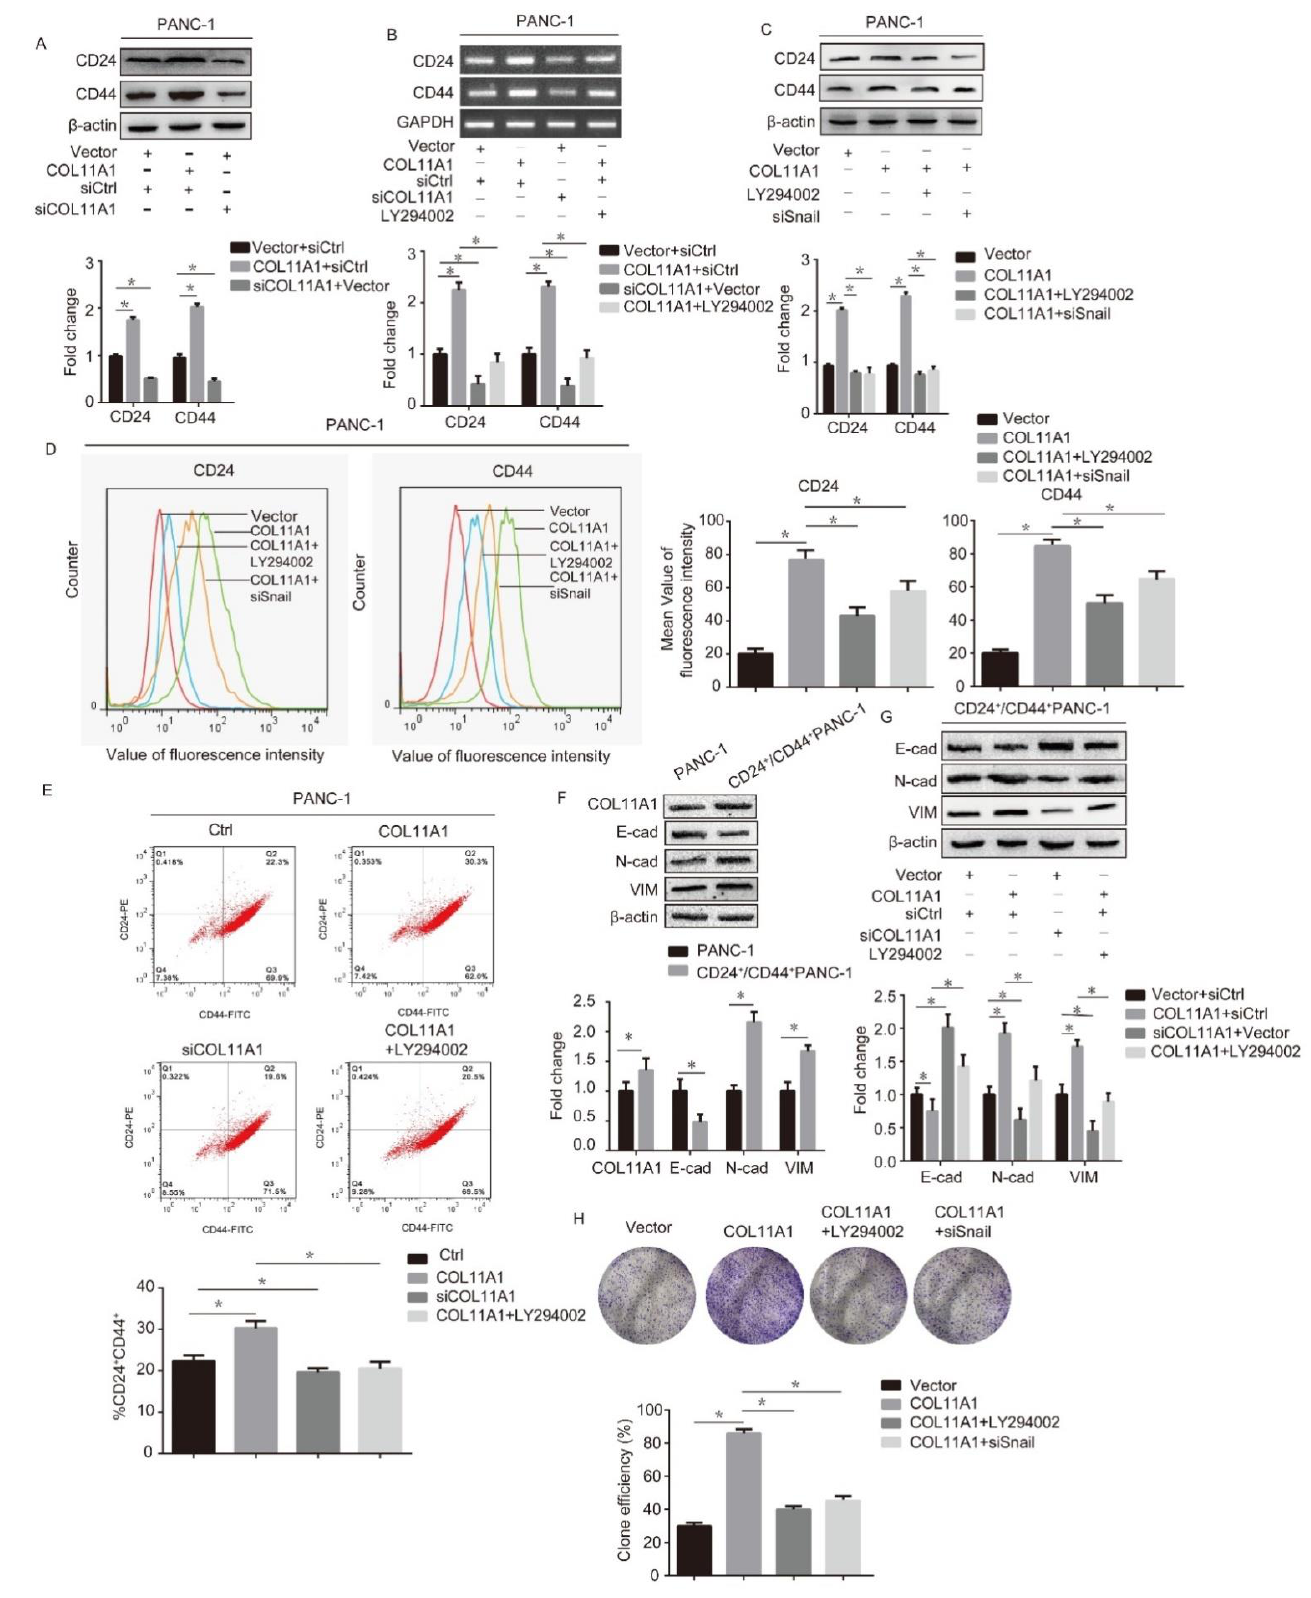
Figure 6. COL11A1 enhanced the cell stemness via the AKT/GSK- 3β/Snail signaling pathway : ( A ) Western blotting analysis of cluster of differentiation (CD)-24 and CD44expression levels in PANC- 1 cells treated with pCMV3-COL11A1 or siCOL11A1; ( B )mRNA expression levels of CD24 and CD44 were detected in PANC-1 cells treated with different treatments using real-time polymerase chain reaction (PCR); ( C ) protein expression levels of CD24 and CD44 in PANC-1 cells